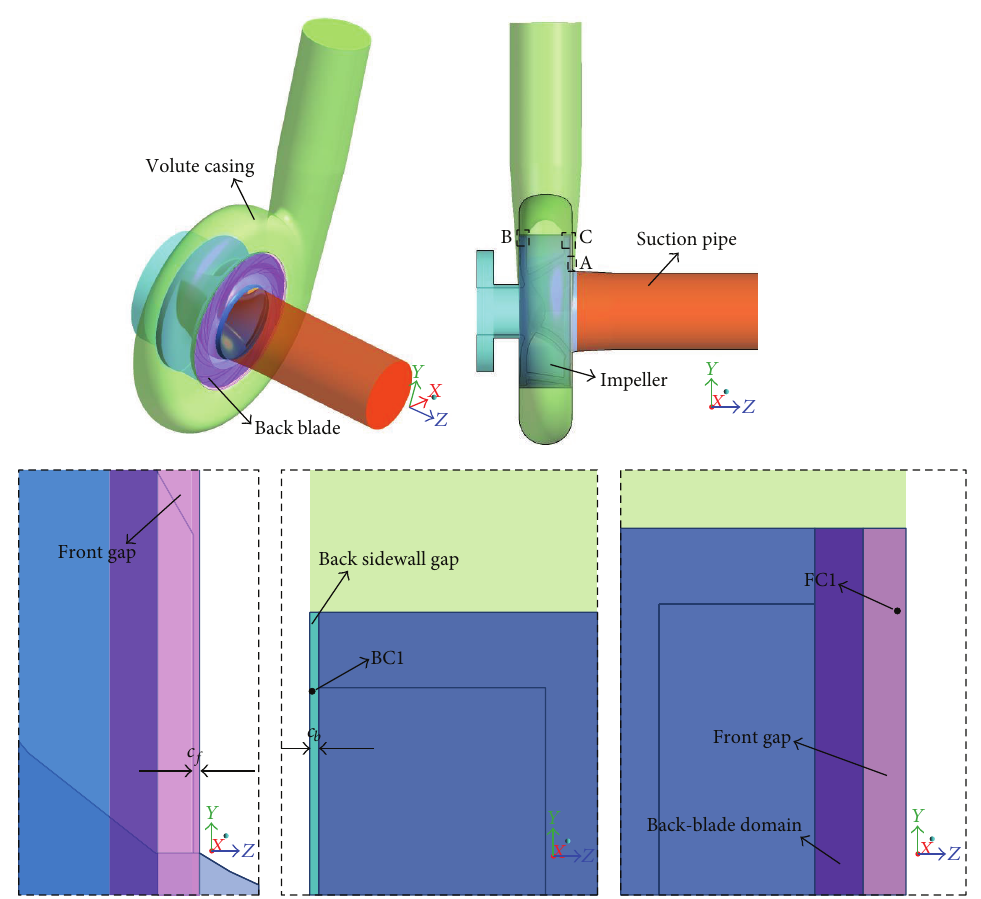
Figure 1: Geometry of the centrifugal